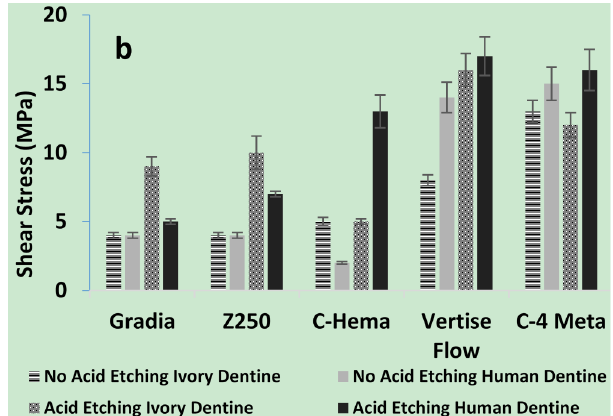
Figure 4. Shear bond strength of experimental and commercial composites, using dentine. ( a ) Shows the effect of ibond along with or without acid etching (20 s); ( b ) shows the effect of No ibond with or without acid etching (20 s) ( n = 5).